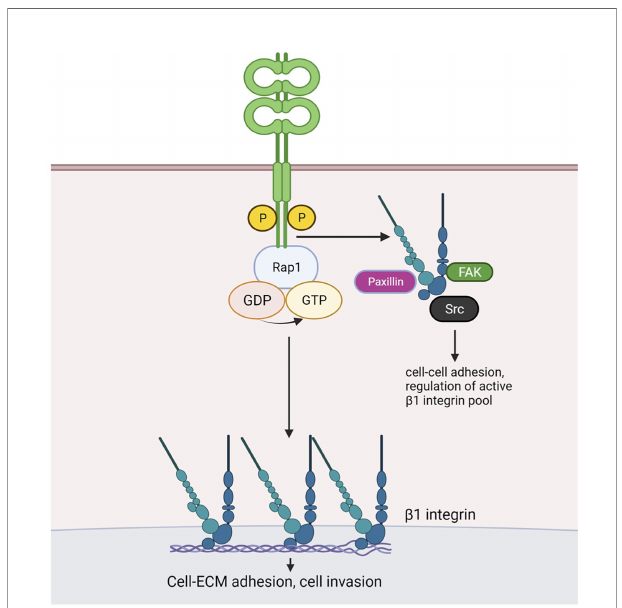
FIGURE 6 | Working model for CAR-dependent regulation of lung cancer cell adhesion. Phosphorylated CAR promotes b 1 integrin and Rap1 activation. Similarly to JAM-A, dimerised CAR may promote interaction of scaffold protein MAGI-1 and the Rap1 GEF PDZ-GEF2, resulting in Rap1 activation. CAR-mediated Rap1 activation promotes cell-ECM adhesion and may enhance  b 1 integrin activity. The latter may in turn be involved in CAR- mediated promotion of cell invasion. Phosphorylated CAR may recruit b 1 integrins and/or focal adhesion components Src, FAK and Paxillin to the membrane to regulate cell-cell adhesion and to distally control focal adhesion activity. Figure created with